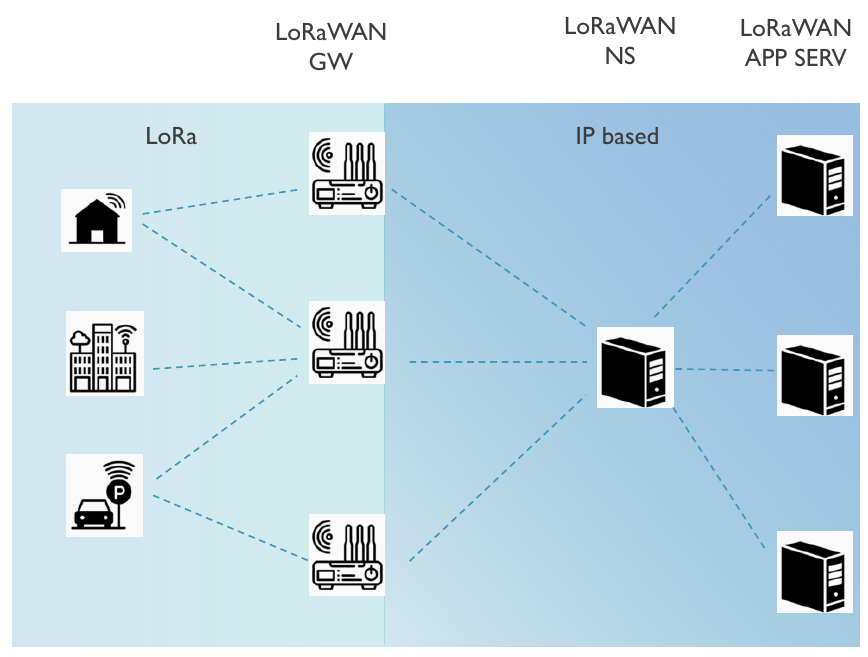
Figure 3. LoRaWAN network